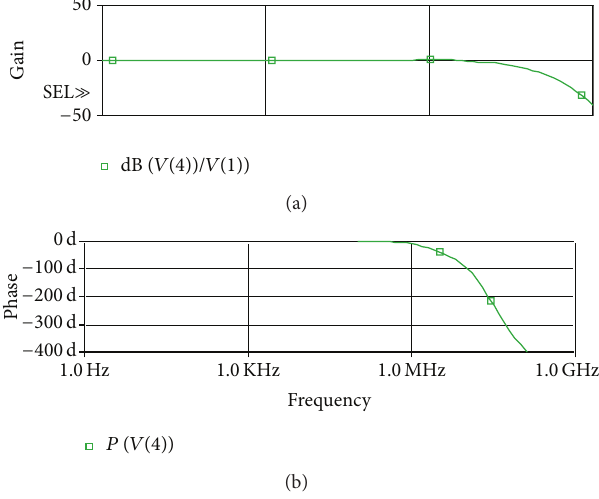
Figure 10: Gain (dB) and phase (deg) response of second-order voltage-mode all-pass filter of Figure